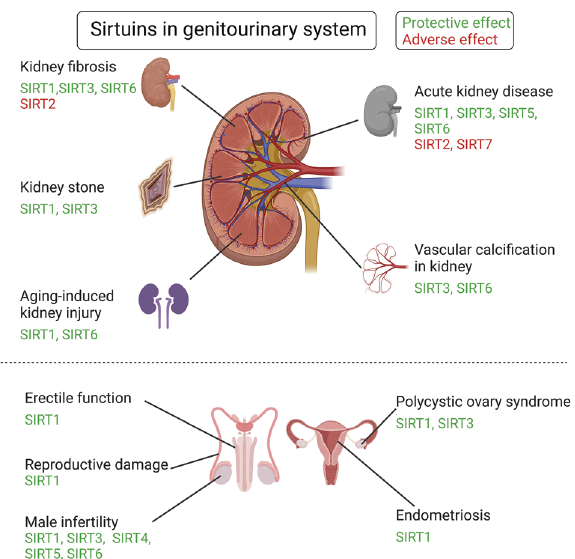
Fig. 15 The roles of SIRTs in genitourinary system. SIRT protein family is involved in common of urogenital system including acute kidney disease, CKD (such as kidney fi brosis, kidney stone, aging- induced kidney injury, and vascular calci fi cation in kidney), and genital system disease (mainly including erectile function, repro- ductive damage, male infertility, PCOS and endometriosis). SIRT1 play a protective effect in aforementioned disease. Moreover, the positive effects of SIRT3 and SIRT6 have been demonstrated in acute kidney disease, kidney fi brosis, vascular calci fi cation in kidney, and male infertility. However, SIRT3 also play a protective role in kidney stone and PCOS, and SIRT6 is protectively associated aging-induced kidney injury. Besides, SIRT4-5 contribute to the remission of male infertility. Additionally, SIRT2 and SIRT7 can aggravate the occur- rence of acute kidney disease, and SIRT2 also can aggravate the occurrence of kidney fi brosis.